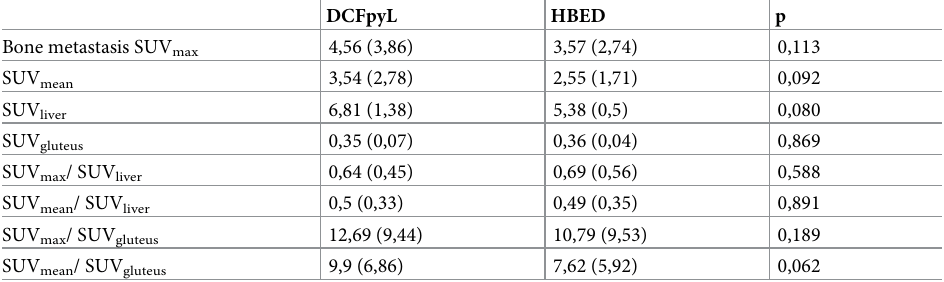
Table 2. Quantitative results in bone